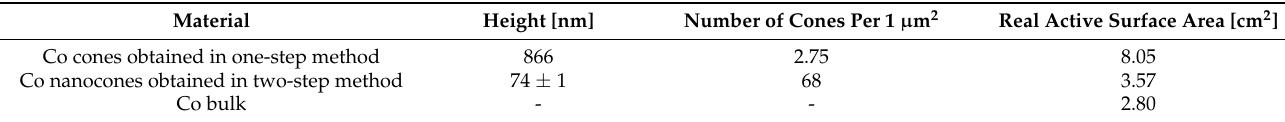
Table 1. Determined values of real active surface area for all